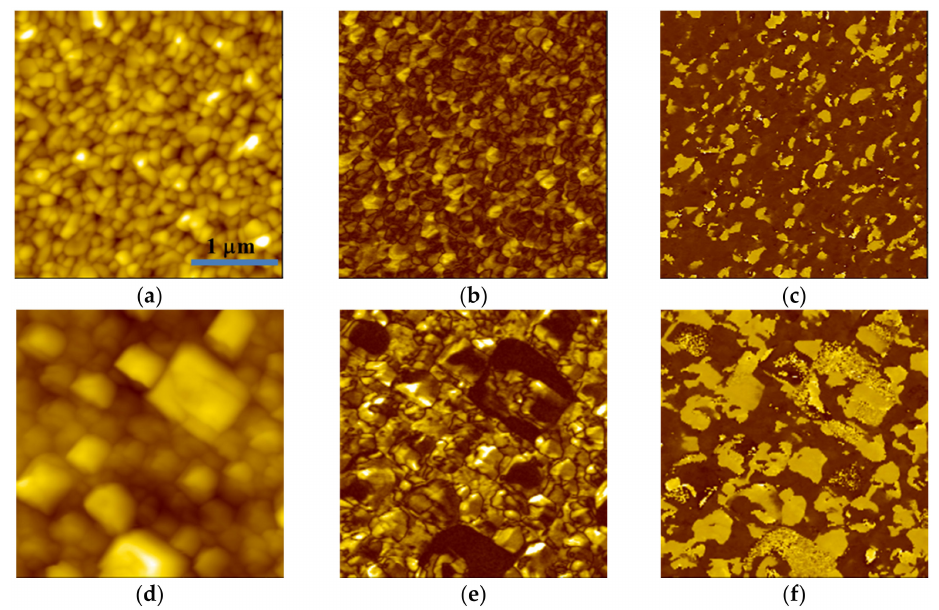
Figure 1. Topography images of BiFe 0.95 Mn 0.05 O 3 (BFMO) films with the deposition at oxygen pressures of ( a ) 2 Pa and ( d ) 10 Pa respectively, with the ( b , e ) corresponding piezoresponse force microscopy (PFM) amplitude images and the ( c , f ) phase